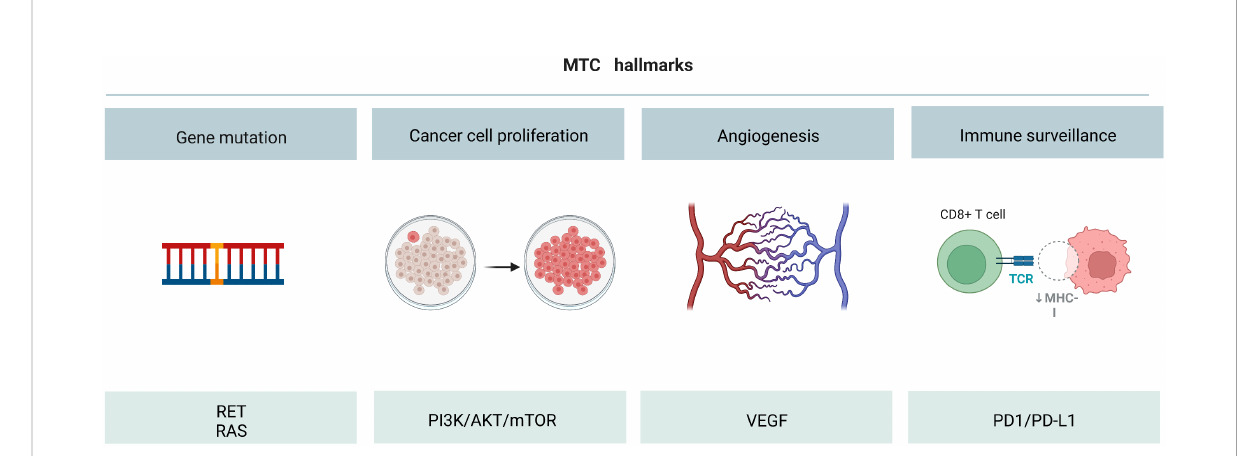
FIGURE 7 Overall diagram of MTC initiation, cell survival increase, angiogenesis and immune